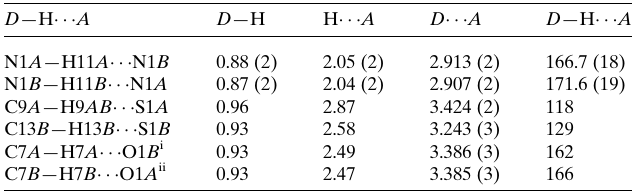
Table 1 Hydrogen-bond geometry (A˚ , (cid:2) ).